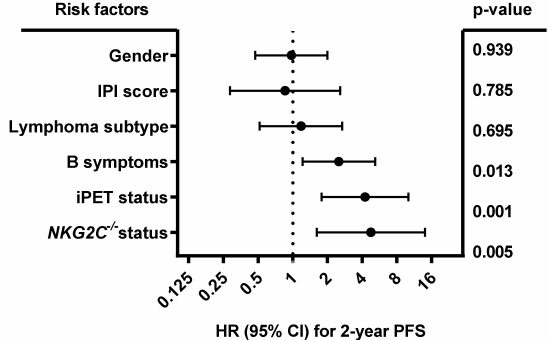
Figure 3. Forest plot of risk factors for 2-year PFS. The forest plot visualizes the multivariate analysis of the following parameters: Gender (male vs. female), IPI (0–3 vs. 4–5), lymphoma subtype (DLBCL vs. other), B symptoms (A vs. B), iPET status (favorable vs. unfavorable iPET), and NKG2C − / − status ( NKG2C − / − vs. NKG2C +/ − or NKG2C +/+ ). The analysis showed that besides B symptoms and iPET status, the NKG2C status is an independent prognostic marker of 2-year PFS in B-NHL patients. Due to loss of follow up, data were available for 379 out of 441 patients. CI (confidence interval), HR (hazard ratio), PFS (progression-free survival at end of